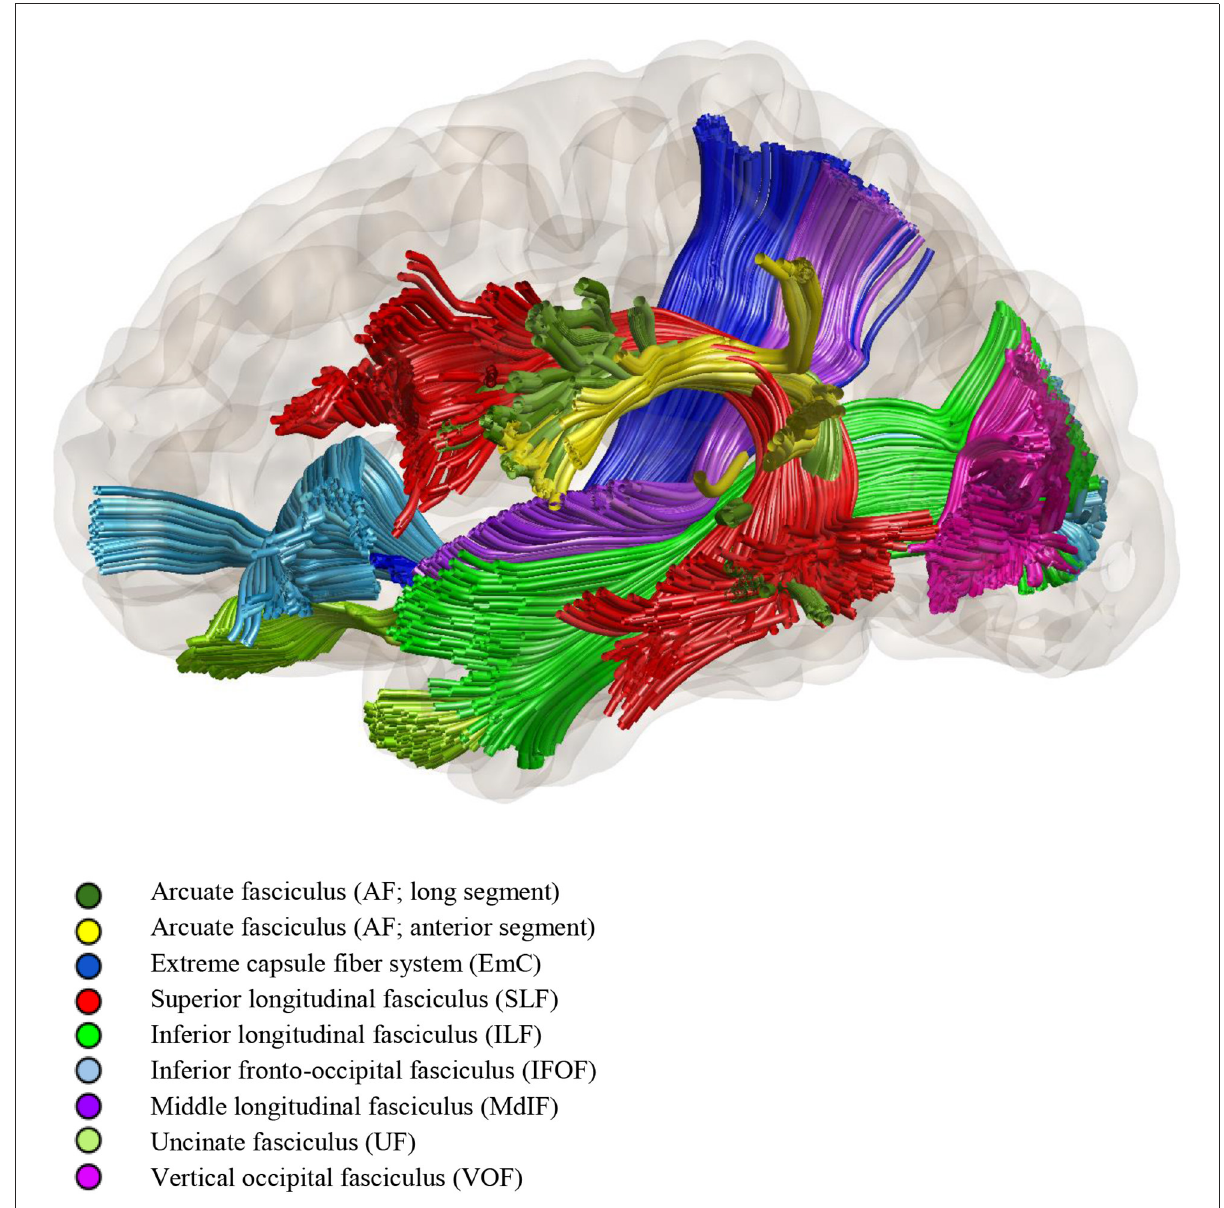
FIGURE1 Diffusion tensor tractography of the fascicles involved in language function (by Dr. Loxlan W.